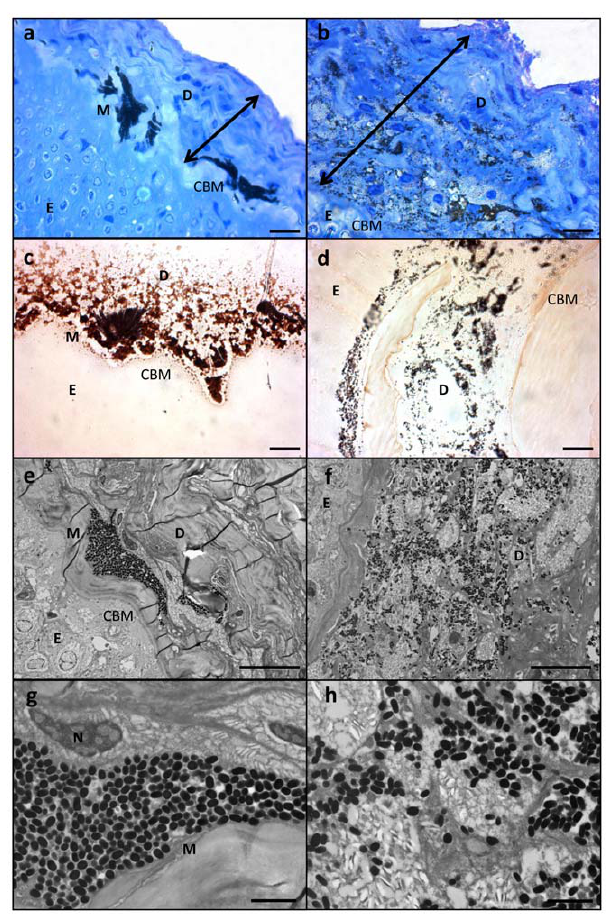
Figure 4. Histological section of LR white resin embedded samples of healthy and diseased Plectropomus leopardus ; a) Healthy section stained with toluidine blue; b) lesion stained with toluidine blue; c) healthy section stained with melanin specific stain Masson-Fontana; d) lesion stained with Masson- Fontana; e) Transmission Electron Micorgraph (TEM) of healthy section; f) TEM of lesion; g) higher magnification of TEM in (e); h) higher magnification of TEM in (f). Scale bars for (a–f)=10 m m; scale bars for (g) and (h)=2 m m. D=dermis (cologne of stroma), E=epithelium, M=melanosome, N=cell nucleus, CBM=caliginous basal membrane. Double headed arrows shows thickening of the integument, characteristic of laboratory induced-melanomas in the Xiphophorus model.